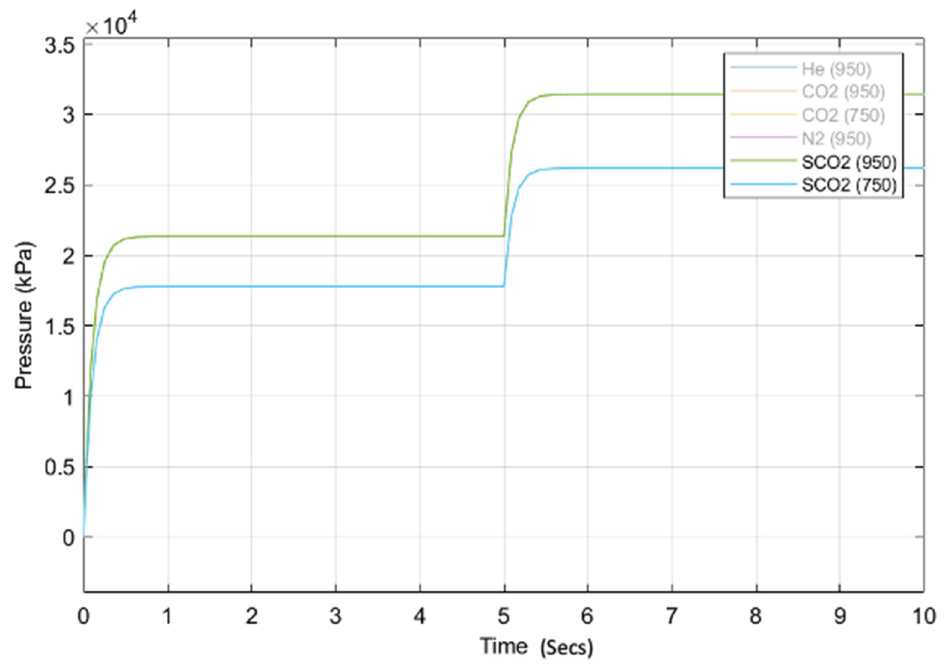
Figure 7. Control-valve response times (secs), with dynamic response and stability of pressures (kPa) for SCO 2 .